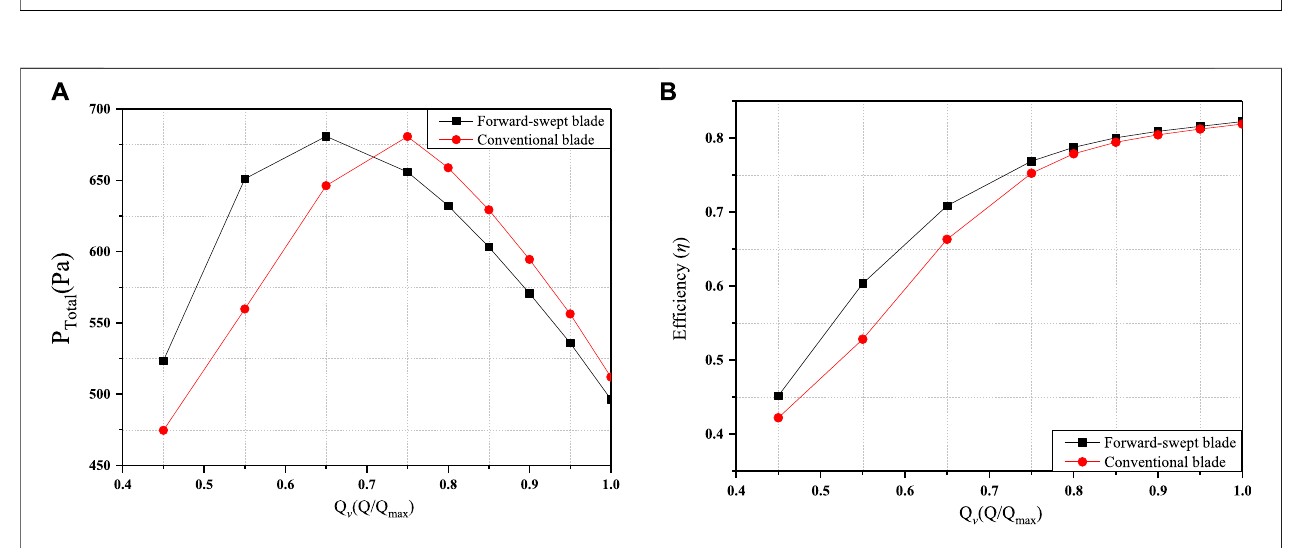
FIGURE 11 | Forward-swept blade characteristic curves: (A) Q v − P total and (B) ef fi ciency.